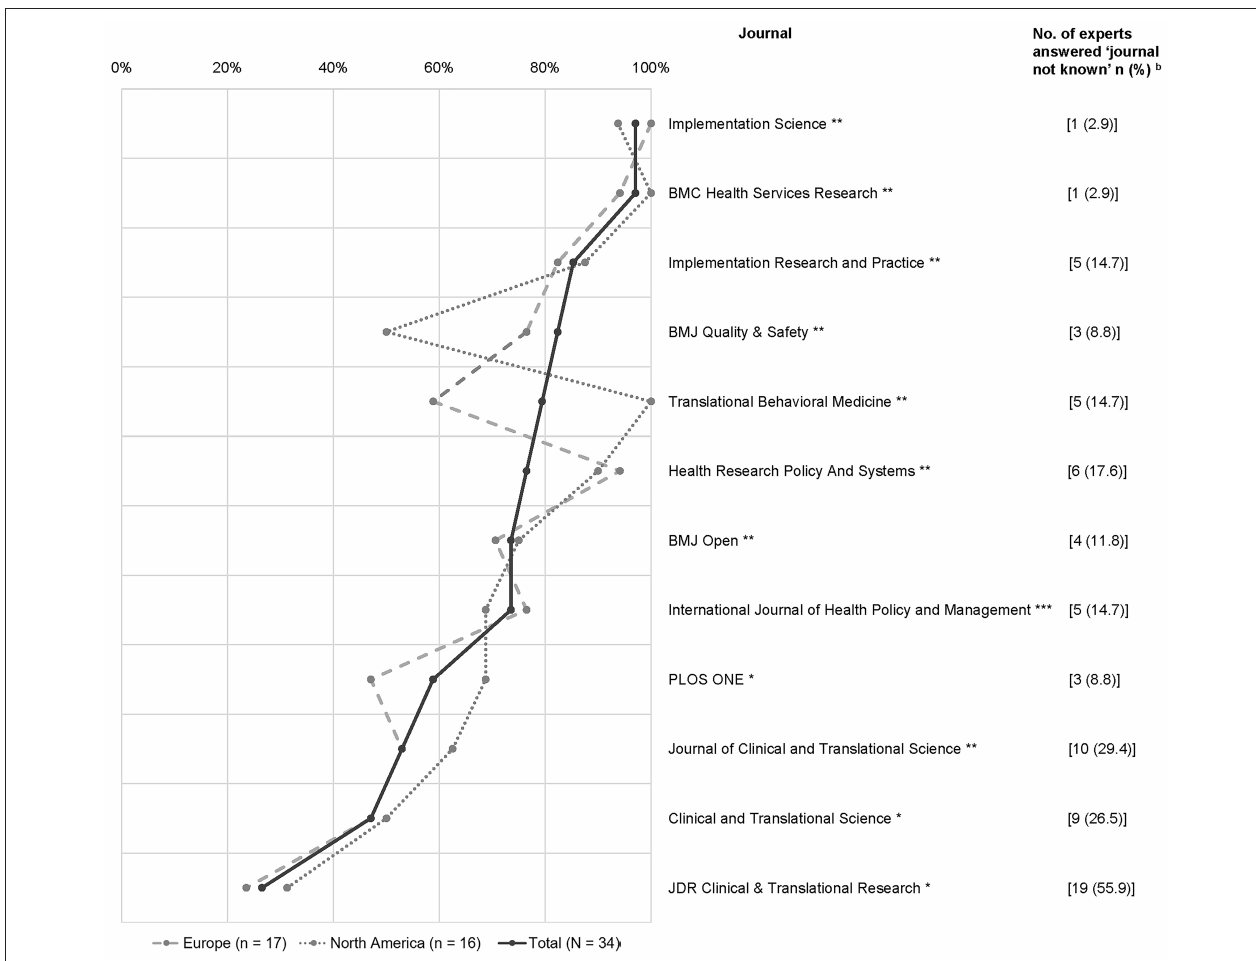
FIGURE 2 | International variation in perceived relevance a of journals by European and North American experts. a Dichotomized as “relevant” (“definitely” or “somewhat”); b answer option “journal not known” set as missing when calculating percentages Country of publication: *USA, **Europe,